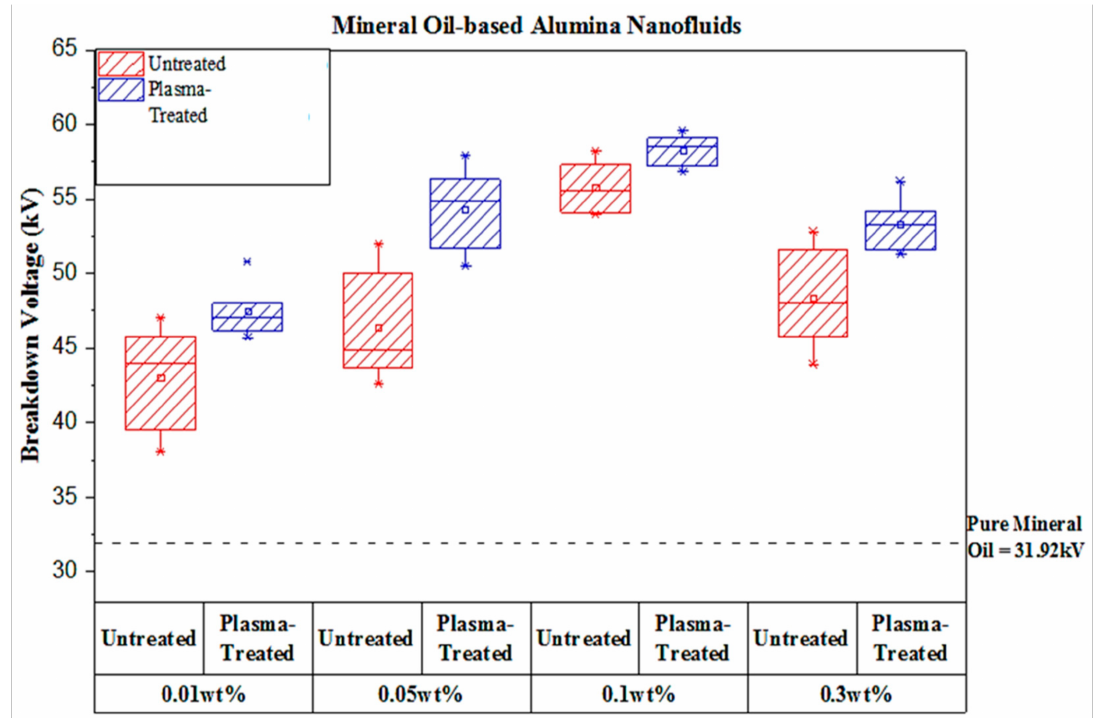
Figure 4. Average AC breakdown voltages of mineral oil-based plasma-treated and untreated alumina nanofluids.